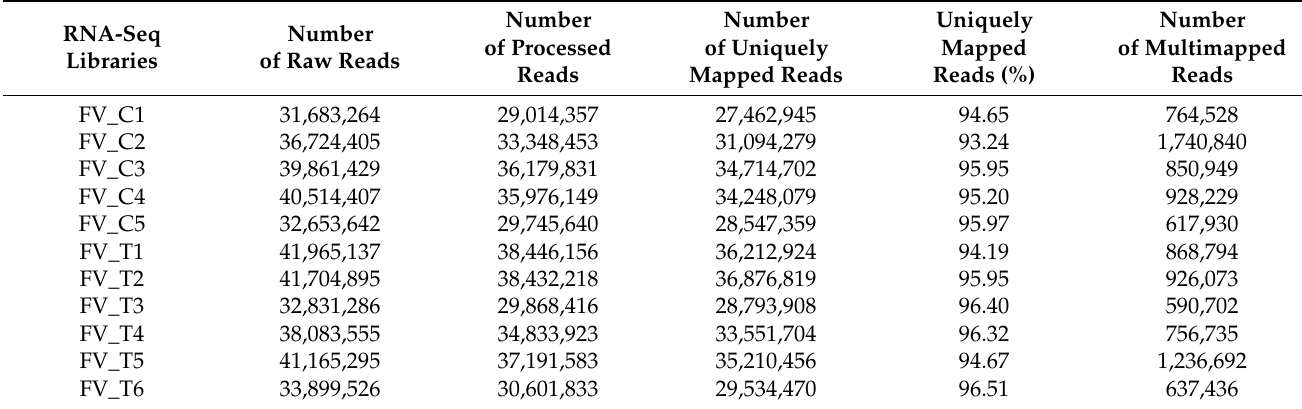
Table 1. The statistical metrics for the RNA libraries.